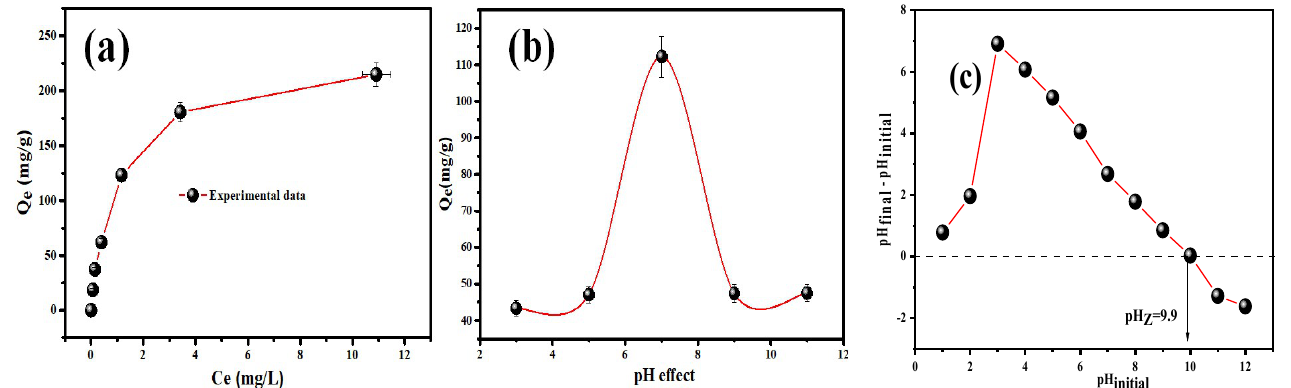
Figure 4. ( a ) Impact of initial fed concentration, ( b ) Effect of solution pH on adsorption of RhB by MgTiO3@g-C3N4 nanohybrid from 50 mg L −1 using 10 mg sorbent at 25 °C, and ( c ) the zero-charge